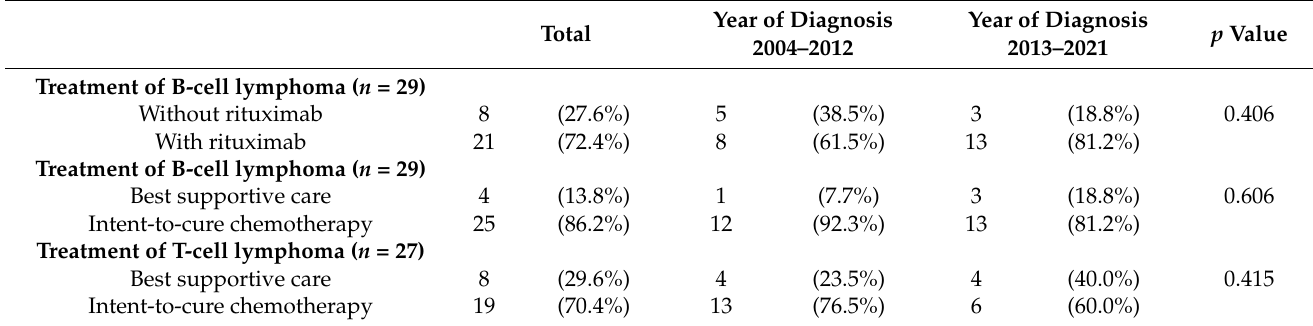
Table 2. Treatment comparisons among lymphoma-associated HLH patients diagnosed in 2004–2012 and